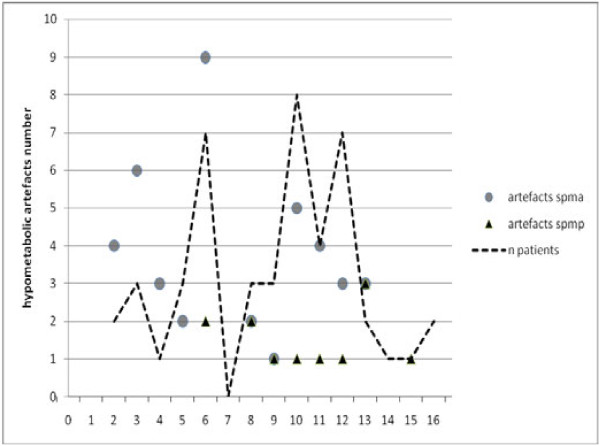
Hypometabolic artifacts observed in patient group using SPM-A and SPM-P analysis. Hypometabolic artifacts observed in patient group (n = 47) using SPM-A analysis (adult control group) and SPM-P analysis (pediatric pseudo-control group). X axis presents the ages (in years). Y axis presents the number of hypometabolic artifacts (false positive results) using SPM-A (lozenges) and SPM-P (circles) analysis. The broken line represents the number of patients at the different ages. Notice that artifacts are observed less frequently using SPM-P than SPM-A, and none was found in patients under 6 years old using SPM-P.